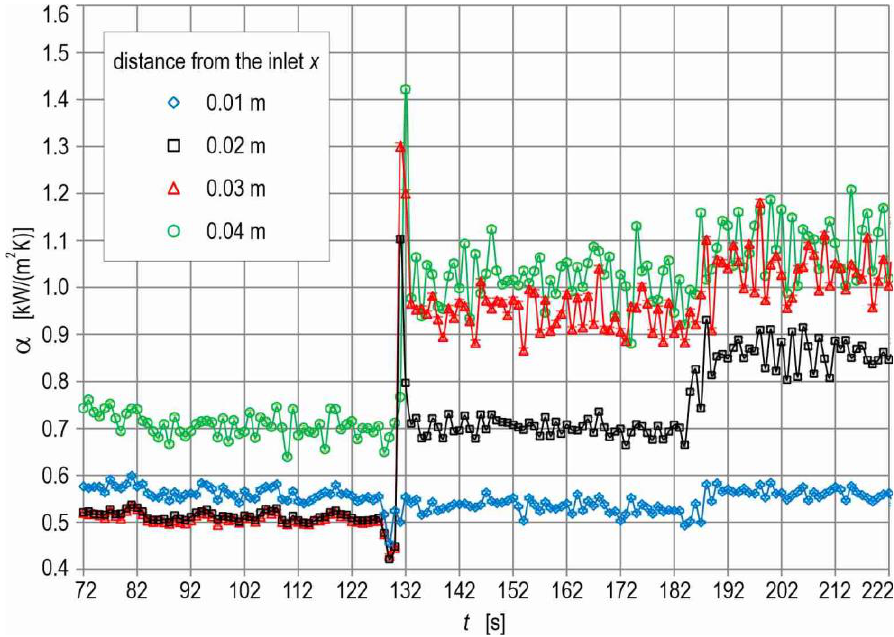
Figure 10. The heat transfer coefficient as a function of time, for four selected distances from the inlet; the subcooled boiling region; and the experimental parameters, as shown in Table 1.